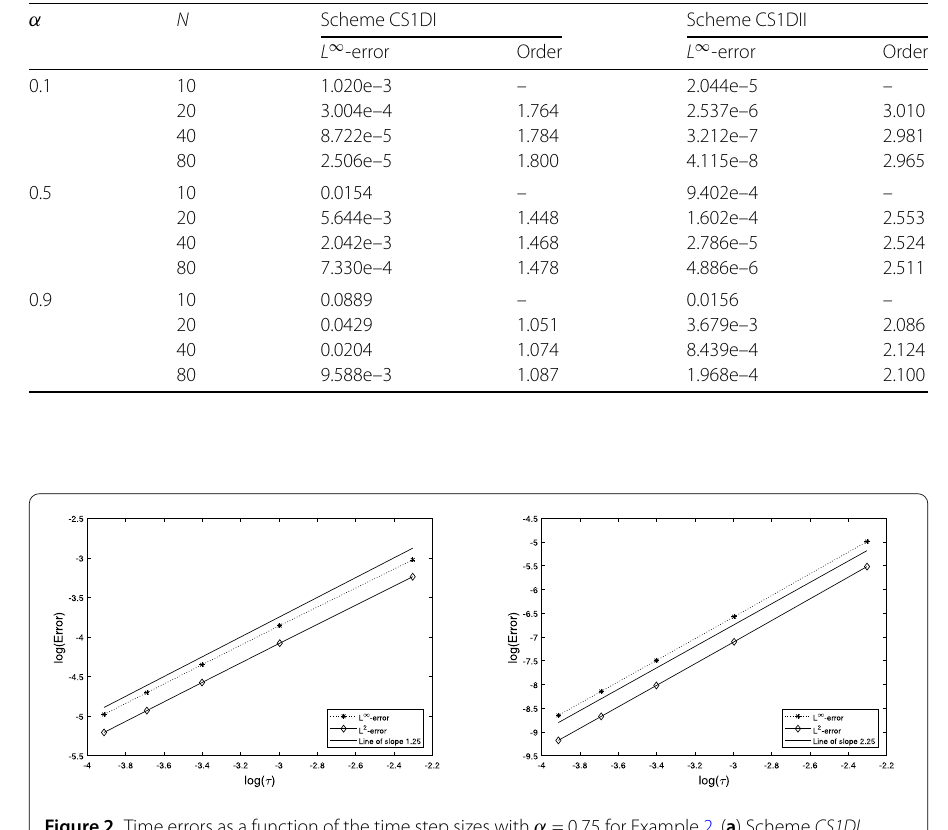
Figure 2 Time errors as a function of the time step sizes with α = 0.75 for Example 2. ( a ) Scheme CS1DI , ( b ) scheme CS1DII